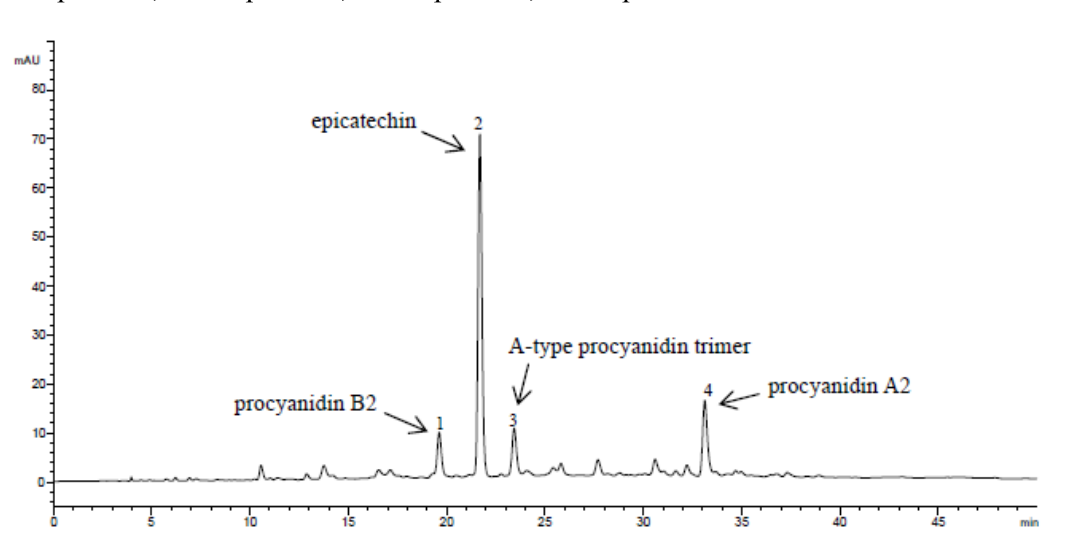
Figure 2. Typical HPLC chromatographic profile of procyanidins of litchi pericarp. 1: compound 1 ; 2: compound 2 ; 3: compound 3 ; 4: compound 4 .